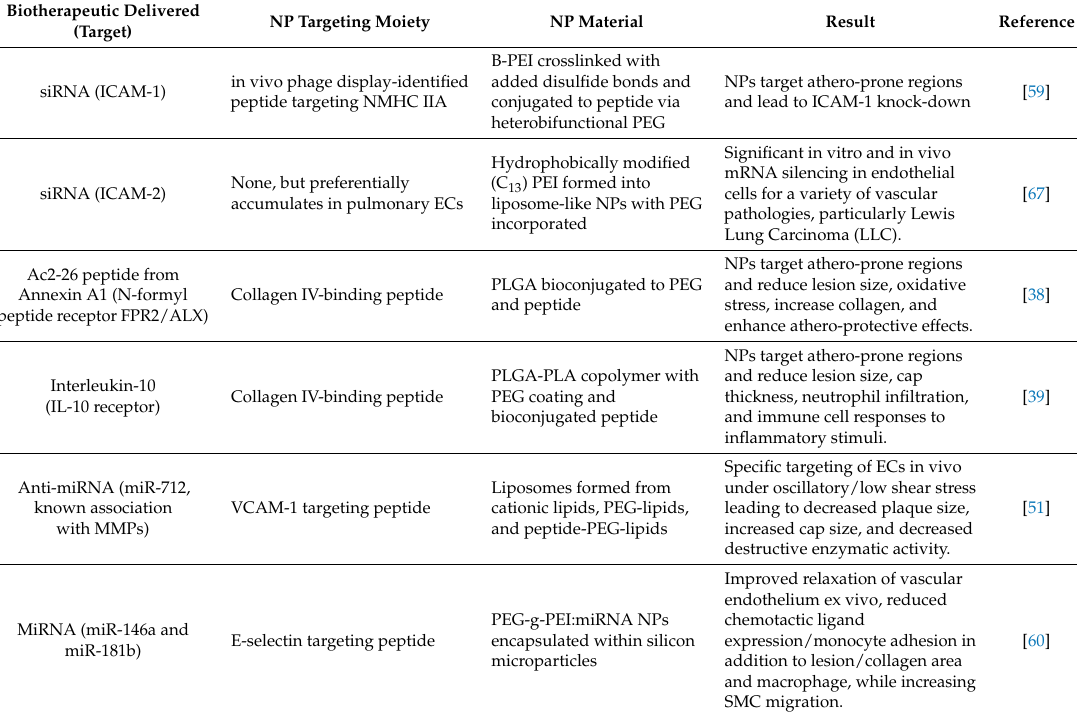
Table 3. Overview of highlights in NP-mediated targeted delivery of biotherapeutics recently used to attenuate